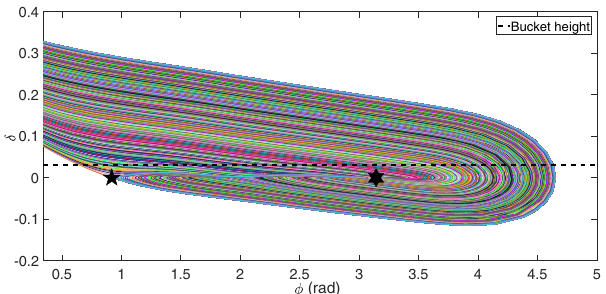
FIG. 11. Longitudinal acceptance including energy-dependent synchrotron radiation loss, the lines in the disparate color stand for the longitudinal motion in different energy deviation with respect to the circulating bunch, and the black star and black hexagram are the same with Fig.